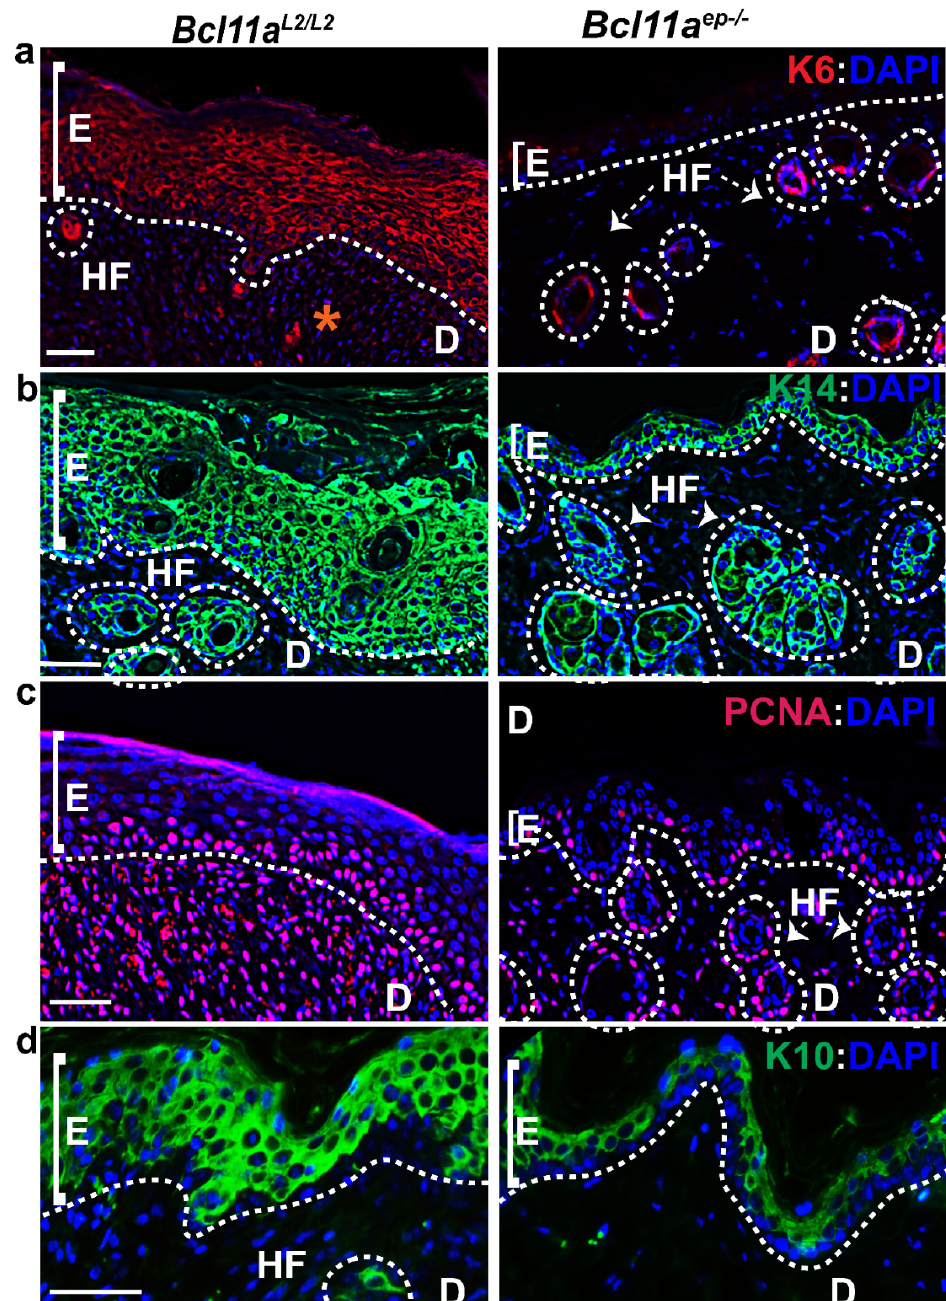
Figure 7. Bcl11a ep − / − mice exhibits rapid re-establishment of epidermal homeostasis through restored expression of epidermal markers during late stages of wound healing (Day 10). ( a – d ) IHC analysis of activated keratinocyte marker K6 (red), re-epithelialization marker K14 (green), active proliferation marker PCNA (red), and early differentiation marker K10 (green) expression in WBAE on Day 10 post wounding samples from Bcl11a L2/L2 versus Bcl11a ep − / − mice. All sections were counterstained with DAPI (blue). White dotted lines separate E from D and outline the HFs. D—Dermis; E—Epidermis; HF—Hair follicle; WBAE—Wound Bed Adjacent Epidermis. Scale bar = 50 µ m. N = 4, where N represents the number of animals of each genotype ( Bcl11a L2/L2 or Bcl11a ep − / − ) involved in the study. Multiple Field of views (FOVs) captured per sample per genotype to determine the statistical significance. “*” in the Figure 7a (left panel) indicates non-specific